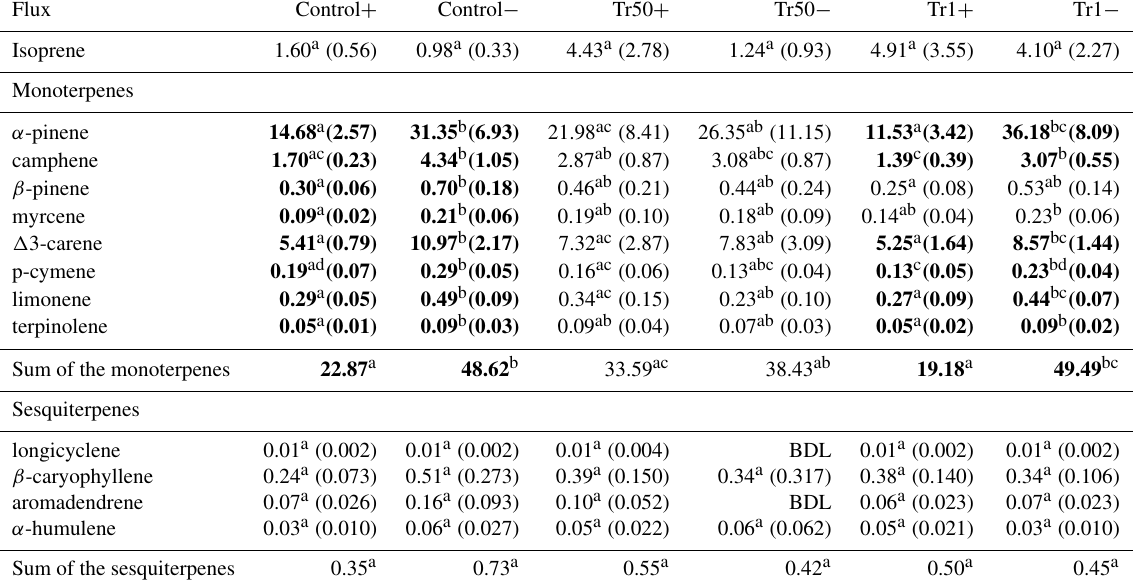
Table 3. Isoprenoid fluxes (µgm − 2 h − 1 ) from the different trenching treatments (Control + ( N = 60), Control − ( N = 28), Tr1 + ( N = 28), Tr1 − ( N = 24), Tr50 + ( N = 17), and Tr50 − ( N = 6)) during periods 1–6, 2015. Fluxes are means (SE: standard error) of the whole data set. BDL = below detection limit of the VOC quantification. The effect of vegetation on fluxes between the plots with vegetation ( + ) and those with bare soil (–) was tested with the Kruskal–Wallis test ( p < 0 . 05). Values were marked in bold if they differed between vegetation treatments. Significant differences in flux rates between the trenching treatments are indicated with different letters (Kruskal–Wallis test; p < 0 .